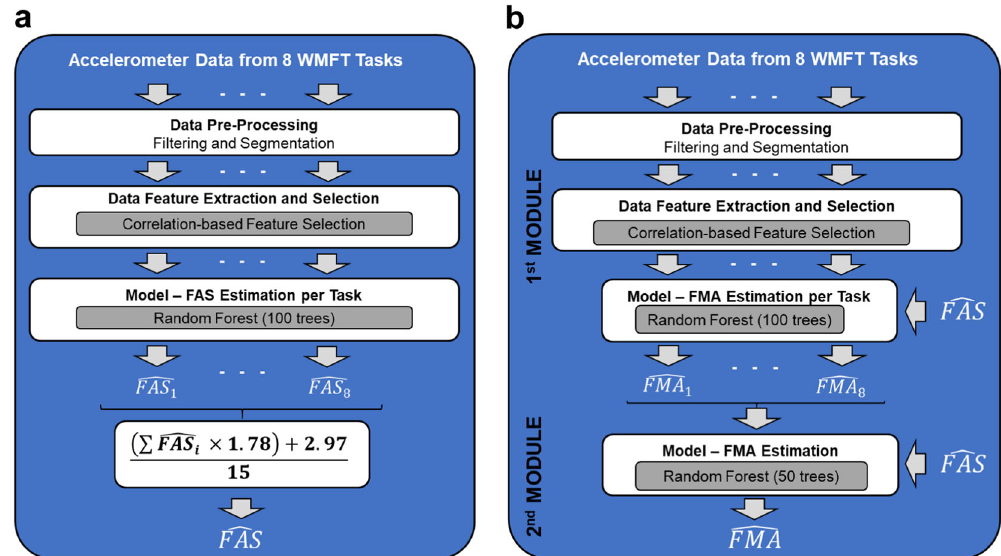
Fig. 6 Graphical illustration of the data analysis pipeline. a FAS score estimation pipeline; and b FMA score estimation pipeline. FAS Functional Ability Scale, FMA Fugl-Meyer